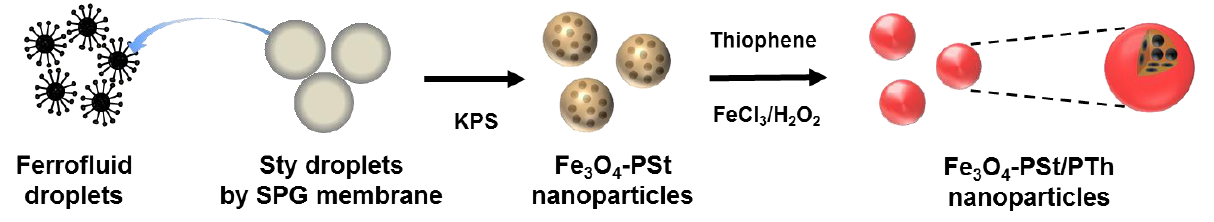
Figure 1. A schematic illustration of the preparation of Fe poly(styrene)/poly(thiophene (Fe